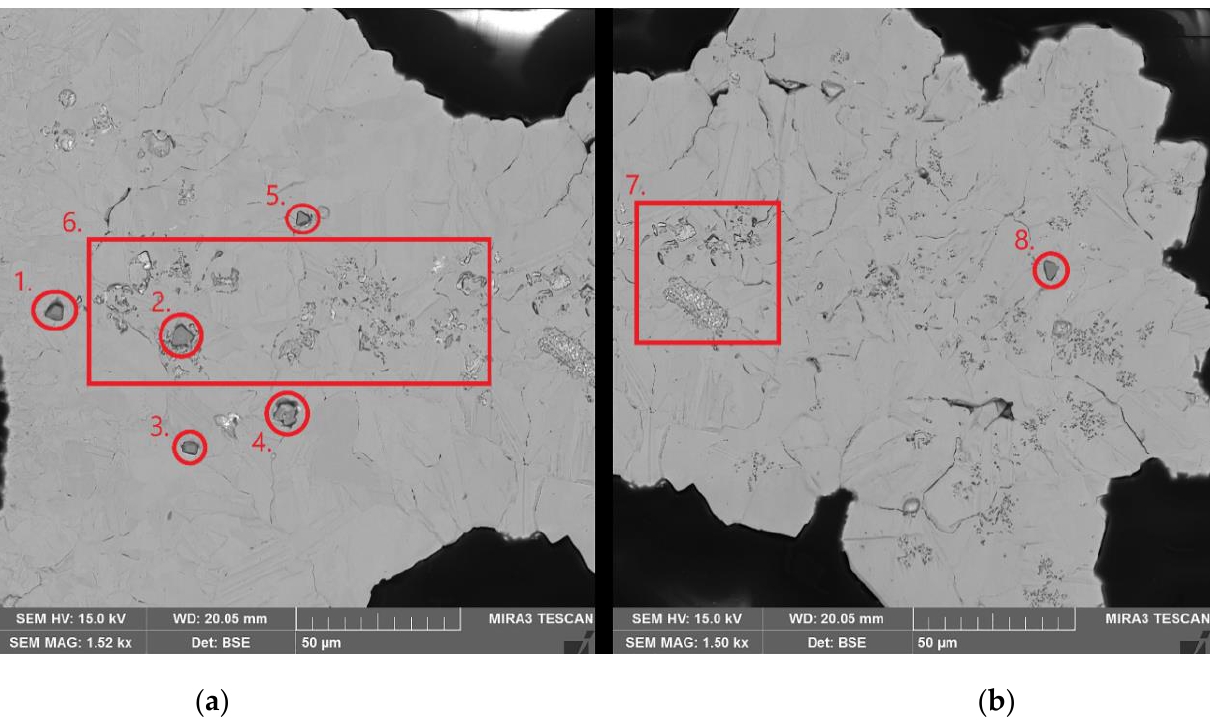
Figure 6. Micrograph of a nodule on the cathode cross-section (SA-5). Clusters of anode slime are seen both at the root ( a ) and the tip ( b ) of the nodule. Numbers indicate the analysis points in Table 6. Table 6. EDS results from points shown in Figure 6.